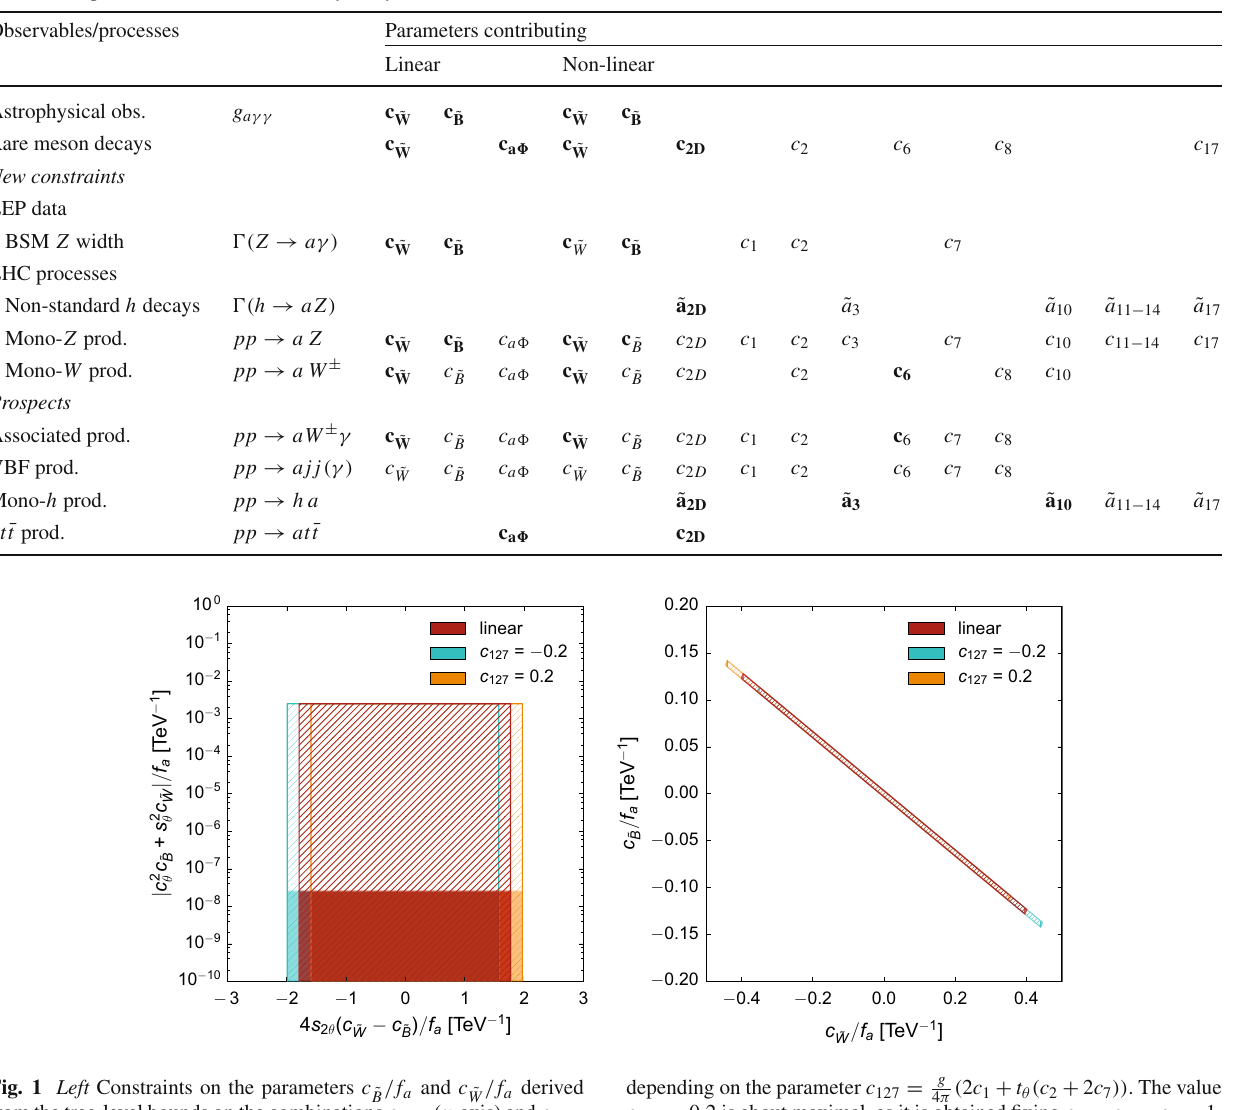
Table 2 Couplings contributing to the observables considered here, stemming from the purely bosonic operators in the linear and non- linear scenarios. The block of new constraints explores the sensitivity of LEP and present LHC data to different operators; see Sect. 6. The last block corresponds instead to the sensitivity analysis from Sect. 7, which